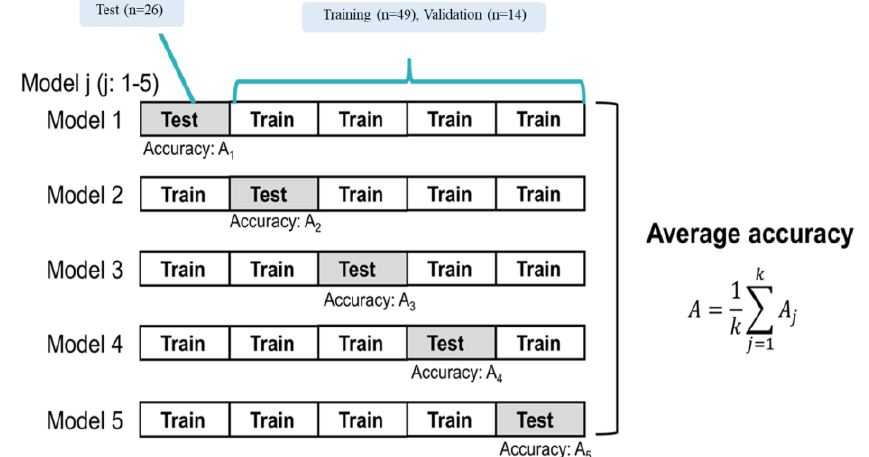
Figure 3. Training and testing with five-fold